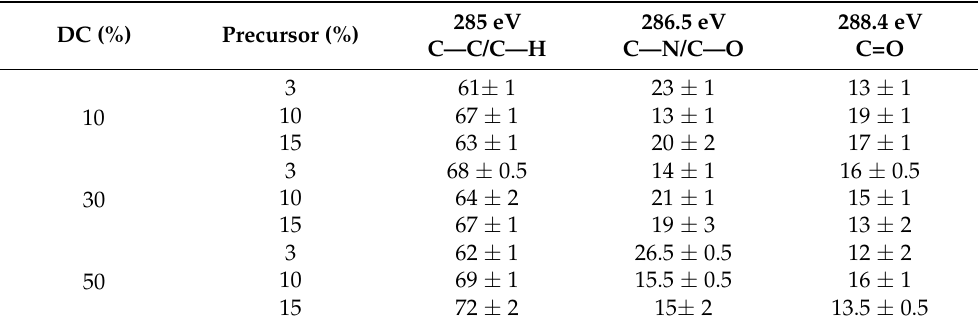
Table 2. Surface composition of plasma-treated ETFE surfaces as a function of applied duty cycle and precursor concentration.